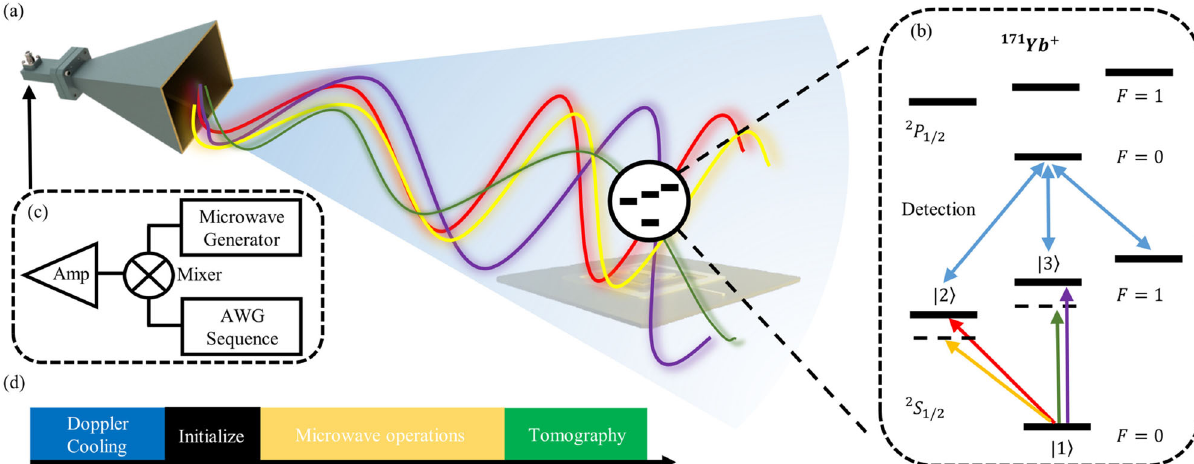
Fig. 1 Experimental scheme for observing topological Euler insulators with a trapped ion. a Schematic of our experimental setup. A single 171 Yb + ion is trapped in a surface-electrode chip trap. b The energy level structure of the 171 Yb + ion. The three states 1 j i , 2 j i , and 3 j i for the Hamiltonian are encoded in (cid:4) (cid:4) the hyper fi ne states F ¼ 0 ; m F ¼ 0